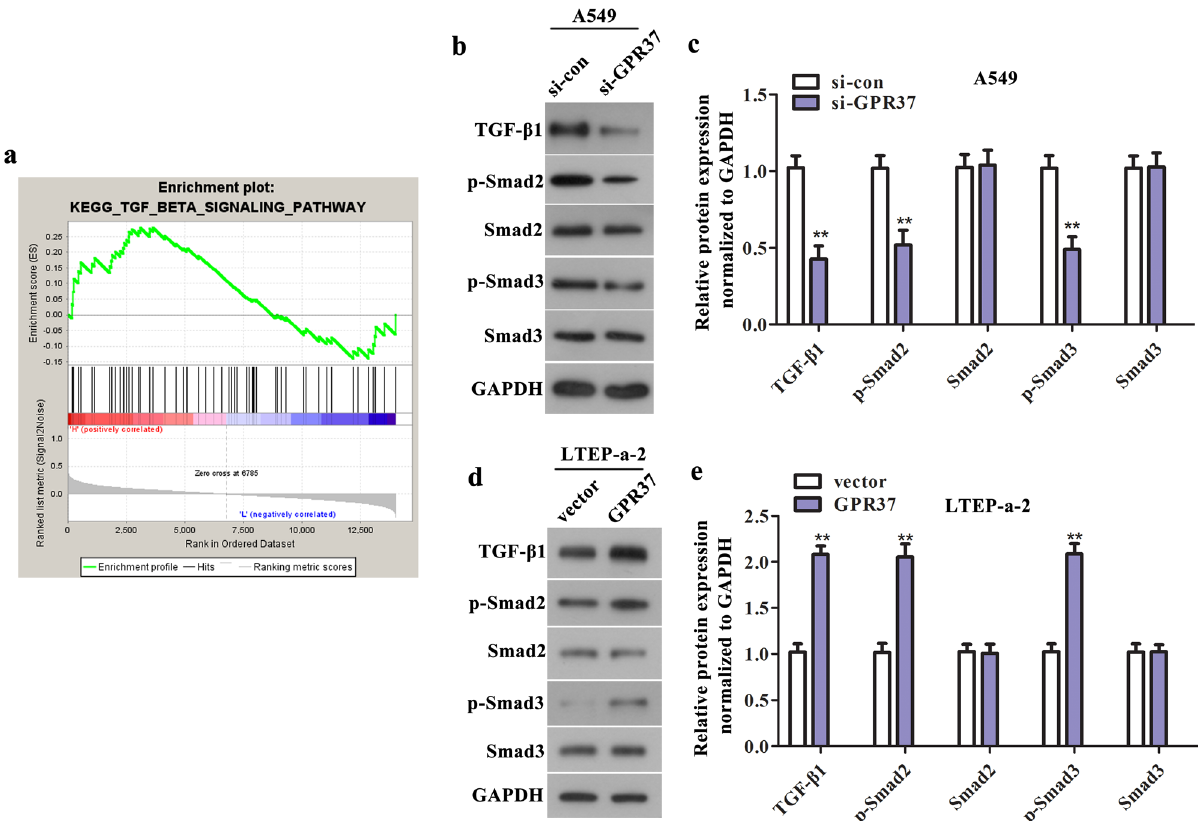
Figure 5: TGF - β /Smad pathway mediated the modulation of GPR37 on the malignant phenotype of LUAD cells in vitro. ( a ) GSEA analysis was performed to identify the pathways closely related to GPR37 expression. Then, western blot assay was performed to measure the expression levels of TGF - β /Smad pathway - related factors in ( b and c ) A549 cells treated with si - GPR37 ( ** P < 0.01 vs si - con group ) and ( d and e ) LTEP - a - 2 cells treated with pcDNA3.1 - GPR37 ( ** P < 0.01 vs vector group )